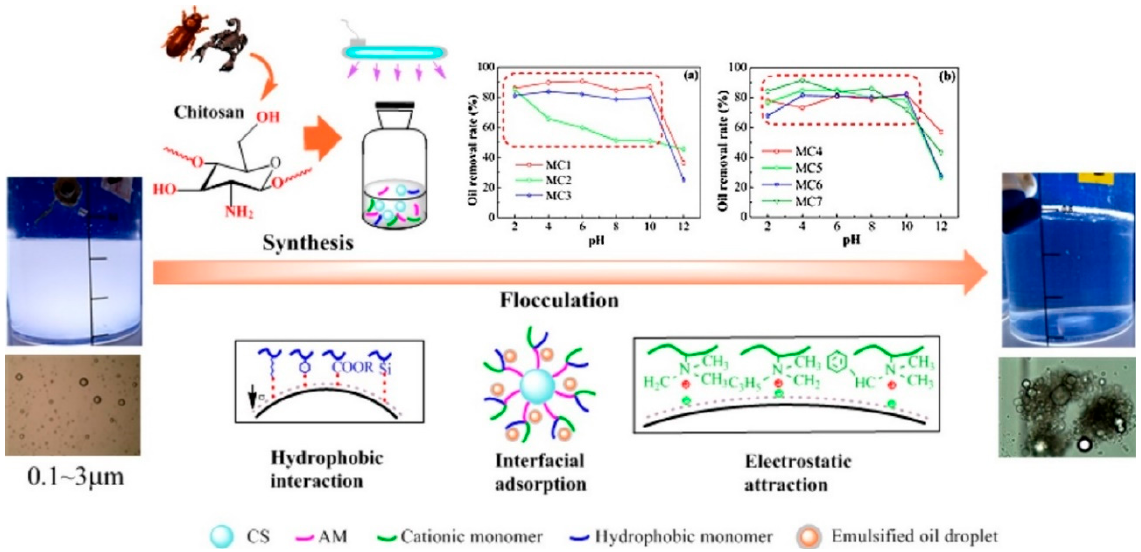
Figure 3. Flocculation mechanism of modified chitosan towards oily wastewater. Reprinted with permission from ref. [42]. Copyright 2020 Elsevier B.V. ( a ) oil removal rate of modified chitosan flocculants with cationic monomers such as ethylacrylyl oxygen ethyl trimethyl ammonium chloride (MC1), dimethyl diallyl ammonium chloride (MC2) and dodecyl polyglucoside (MC3); ( b ) oil removal rate of modified chitosan flocculants with hydrophobic monomer such as photo-initiators